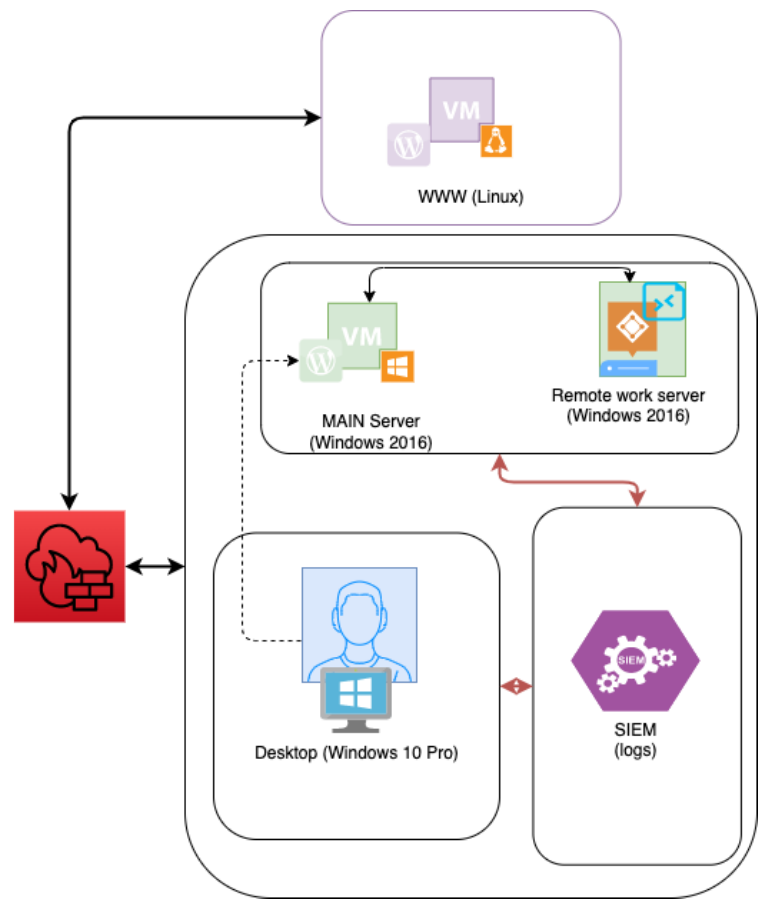
Figure 6. Architecture of organization’s ICT